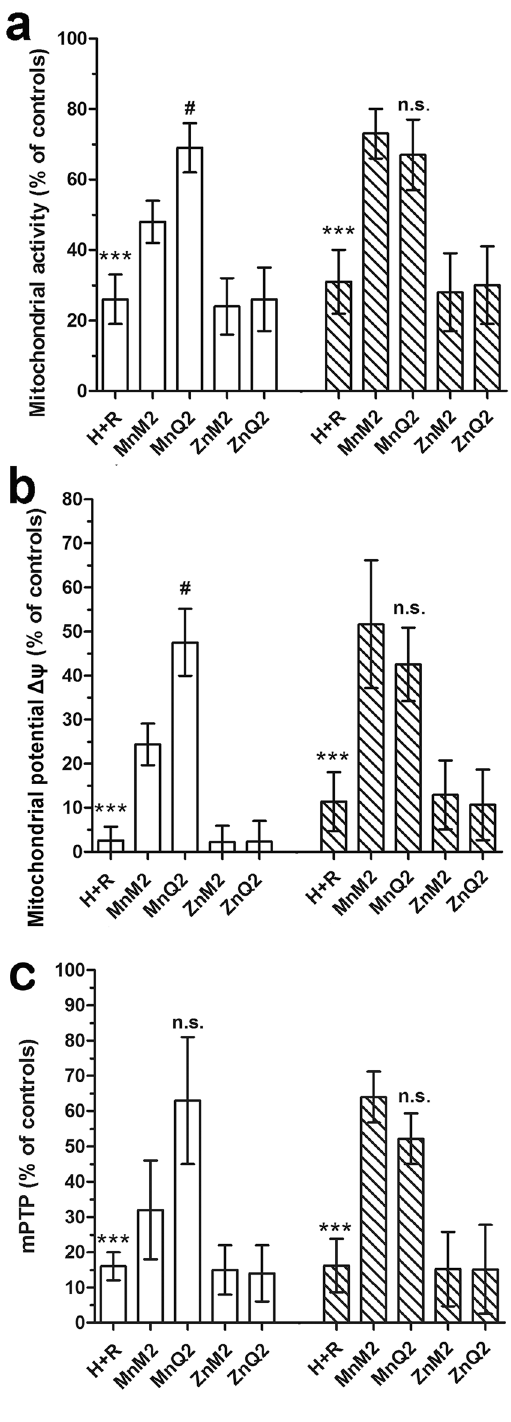
Figure 8. FACS analysis of mitochondrial activity by RSZ ( a ), of mitochondrial membrane potential ( Δψ ) by TMRM ( b ) and of mitochondrial transition pore opening (mPTP) by extinction of calcein fluorescence, evaluated at 1 h (open columns) and 2 h (striped columns) and expressed as percent changes of the untreated controls. All these parameters were decreased by H + R and significantly increased by MnM2 and MnQ2. At the shorter time point (1 h), MnQ2 was more effective than MnM2. *** p < 0.001 vs. controls, MnM2 and MnQ2; (one-way ANOVA); # p < 0.05, n.s. not significant vs. MnM2 (Student’s t